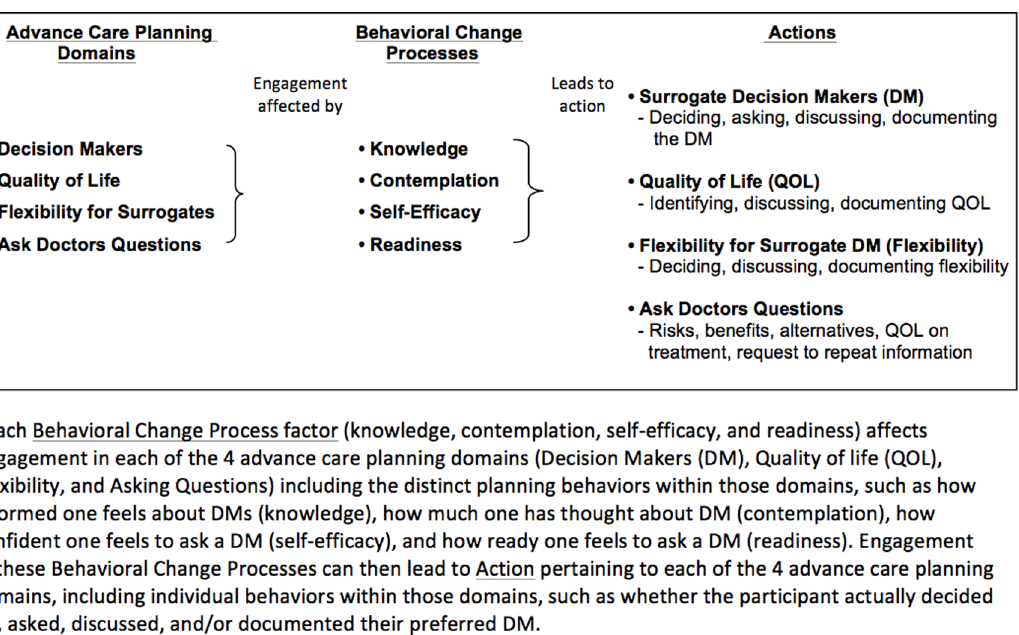
Figure 1. *Each Behavioral Change Process factor (knowledge, contemplation, self-efficacy, and readiness) affects engagement in each of the 4 advance care planning domains (Decision Makers (DM), Quality of life (QOL), Flexibility, and Asking Questions) including the distinct planning behaviors within those domains, such as how informed one feels about DM (knowledge), how much one has thought about DM (contemplation), how confident one feels to ask a DM (self-efficacy), and how ready one feels to ask a DM (readiness). Engagement in these Behavioral Change Processes can then lead to Action pertaining to each of the 4 advance care planning domains, including individual behaviors within those domains, such as whether the participant actually decided on, asked, discussed, and/or documented their preferred DM.